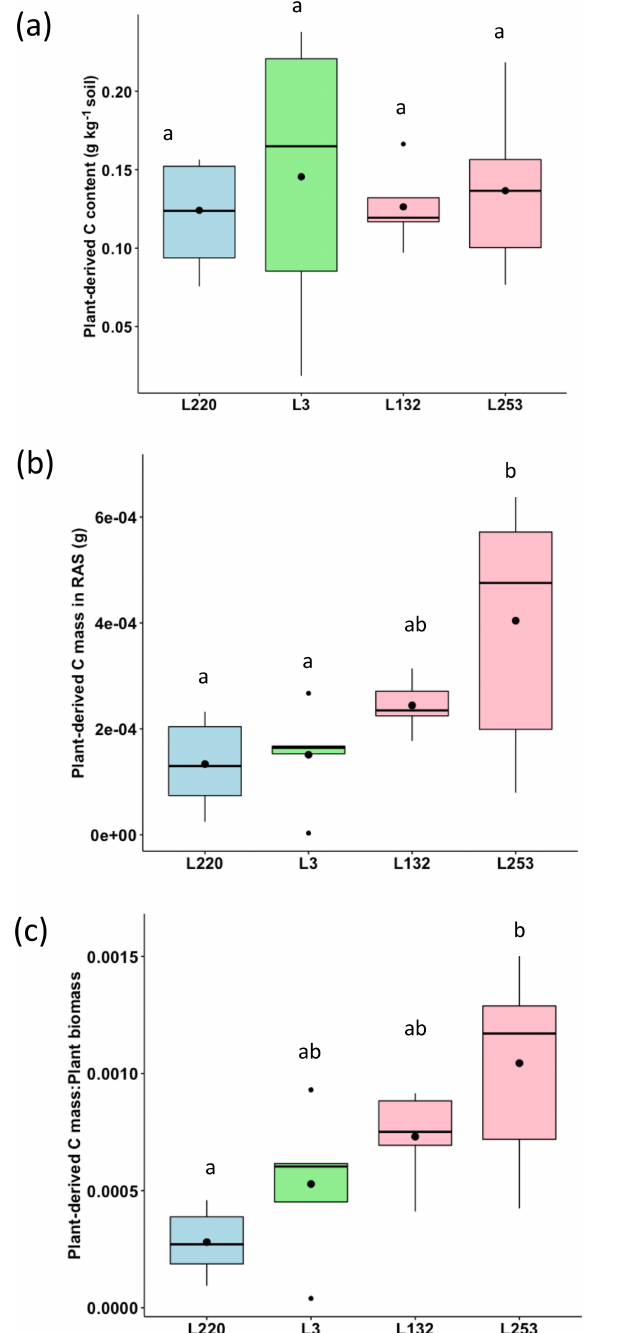
Figure 2. (a) Plant-derived carbon content (PDCC; gCkg − 1 soil) in the root-adhering soil (RAS) of the four pearl millet lines. (b) Plant-derived carbon mass deposited (PDCD; gC) in the RAS of the four pearl millet lines. (c) Ratio between the plant-derived carbon mass and the total plant biomass produced by the four pearl millet lines. Black points within the boxes represent the means. Dif- ferent letters indicate significant differences using an ANOVA and the Tukey post hoc test ( p< 0 .